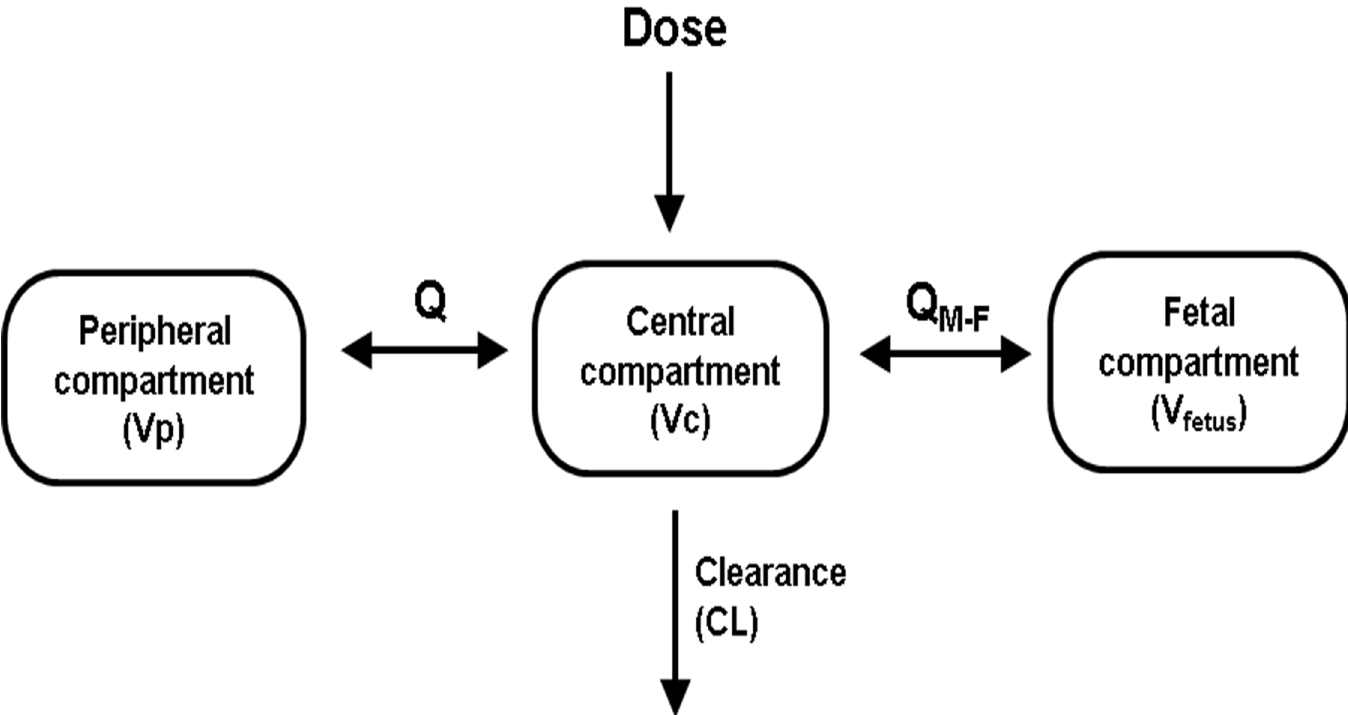
Fig 3. Pharmacokinetic Model. The maternal- fetal pharmacokinetic model of propofol was best fitted using a 2 maternal compartment with a separate fetal compartment model. Vc = maternal central volume of distribution (L), Vp = maternal peripheral volume of distribution (L), Q = inter-compartmental clearance (L/min), CL = clearance from the maternal central compartment (L/min), Q M-F = transfer rate between maternal and fetal compartment (L/min), V Fetus = volume of distribution of fetal compartment